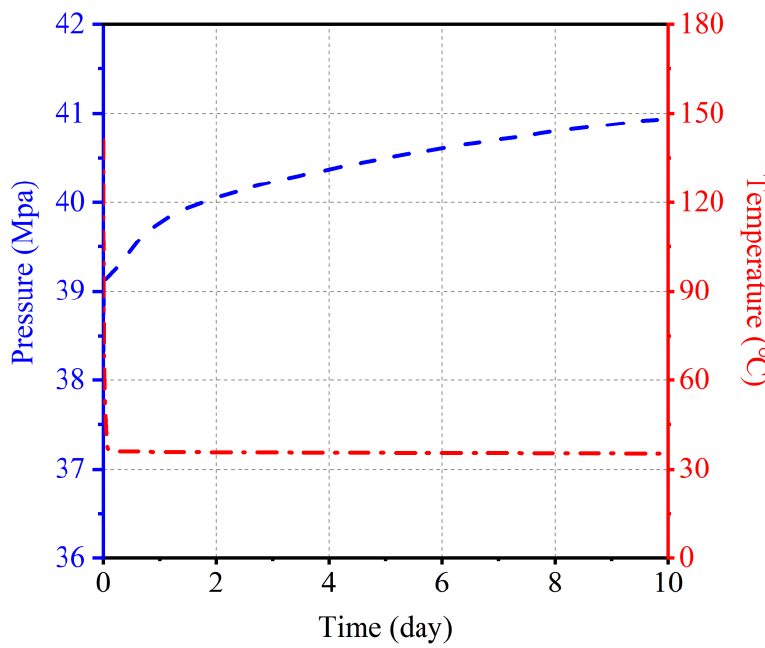
Figure 5. Initial temperature and pressure values at the water injection point.